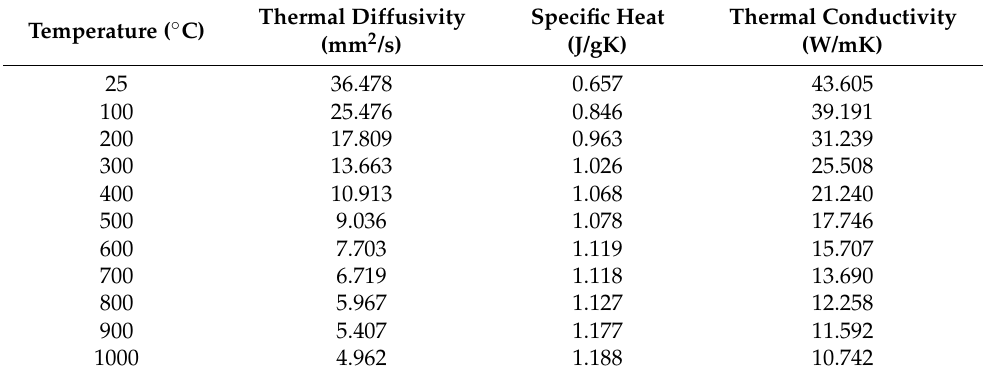
Table 8. Thermophysical properties of the aged samples obtained from slabs 14 and 16. Average values of the two samples.